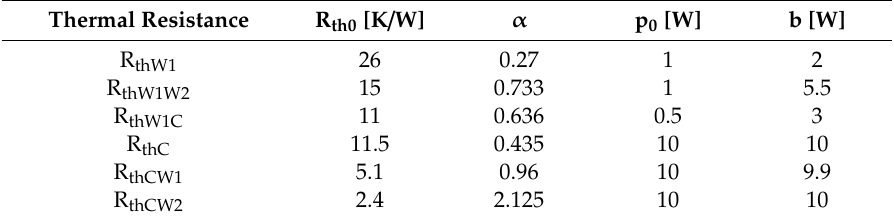
Table 2. Values of the parameters in Equation (2) for a planar transformer.